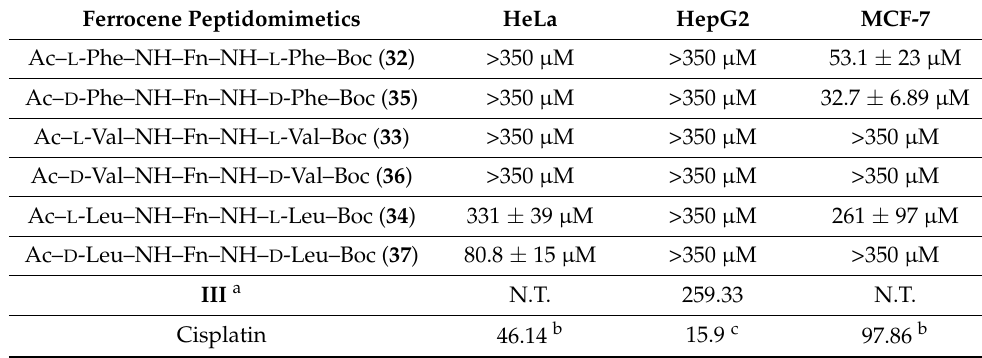
Table 2. IC 50 values calculated from dose-response curves on HeLa, HepG2 and MCF-7 cells. Ferrocene